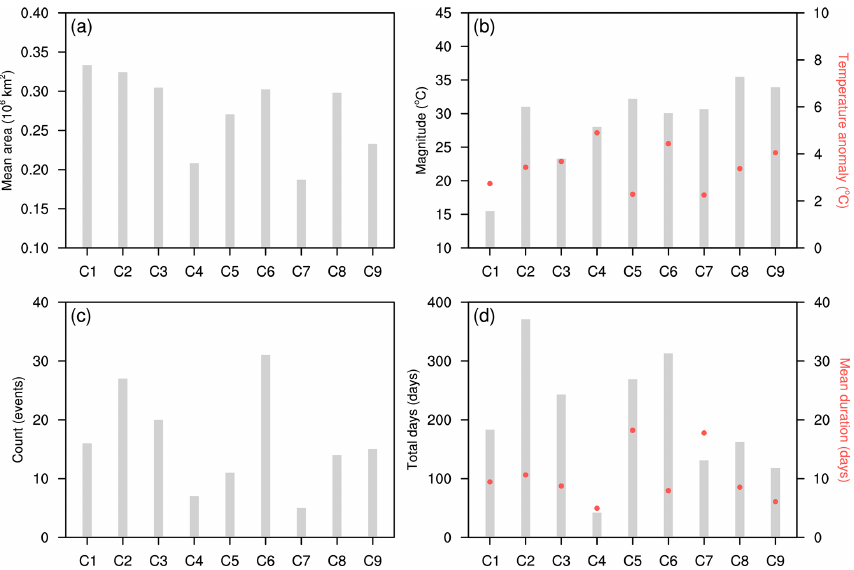
Figure 11. Characteristics of the nine SLDDH clusters during 1961–2014. The average (a) mean area, (b) magnitude (histogram) and temperature anomaly (dot), (c) count, and (d) total days (histogram) and mean duration (dot) of all events per cluster.